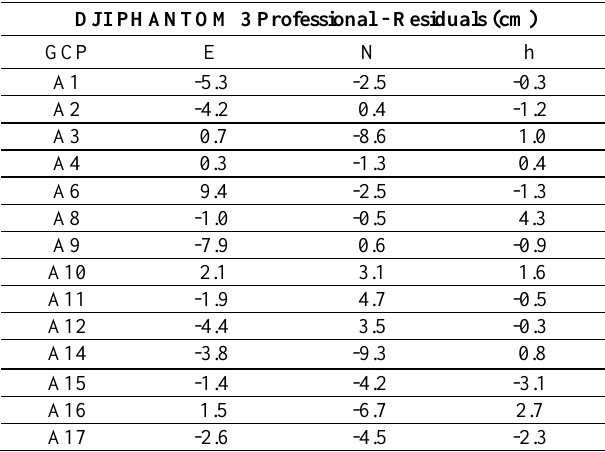
Table 3b. Georeferencing residuals on GCPs measured in nRTK